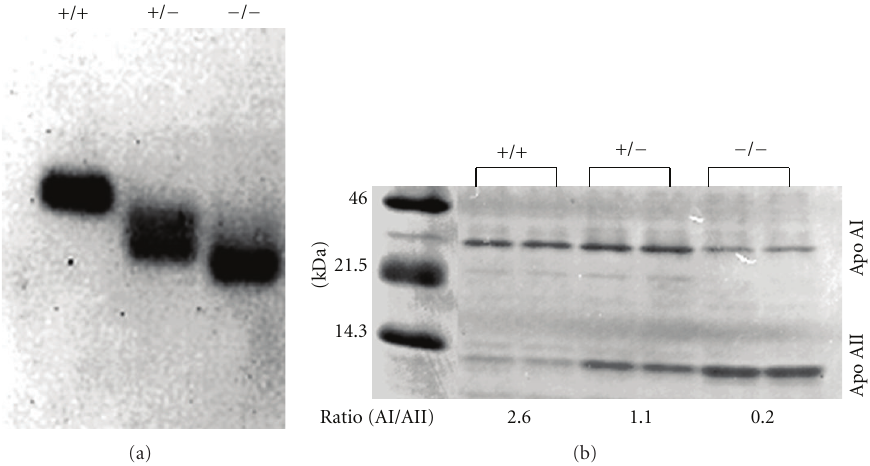
Figure 2: (a) Agarose electrophoresis of HDL in HO-1-knockout mice. 11 µ g protein of HDL fraction was electrophoresed in 1% agarose gel and stained with Nile Red. (b) Change of Apolipoprotein AI/AII ratio in HO-1-knockout mice. 1 µ g protein HDL was subjected to SDS-PAGE and stained with Nile Red.